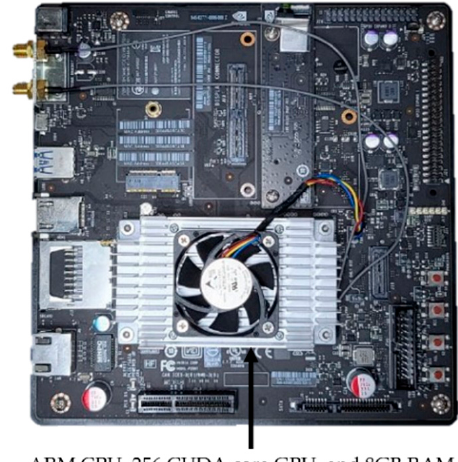
Figure 10. Jetson TX2 embedded system. Table 12. Average processing time of one image by the proposed method (unit: ms). Table 13. Average processing time of one image by Pix2Pix, original CycleGAN, and proposed OSRCycleGAN (unit: ms).